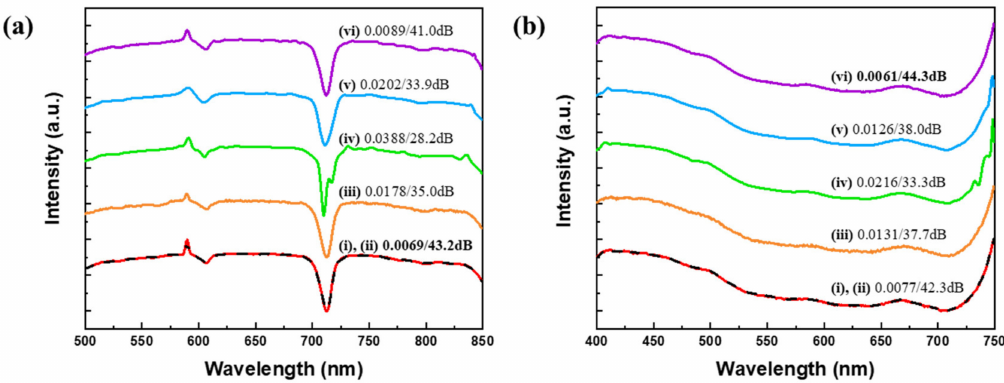
Figure 7. Spectral reconstructions of test spectra in measured datasets: ( a ) spectrum of organic compound dibenzothiophene in USGS dataset, ( b ) spectrum of Munsell color 5PB 2 / 2. The input spectrum (solid red line (i)) is compared with ResCNN (dashed black (ii)), CNN (orange (iii)), sparse recovery: Gaussian 1 (green (iv)), Gaussian 2 (blue (v)), and K-SVD (purple (vi)). The baselines are shifted for